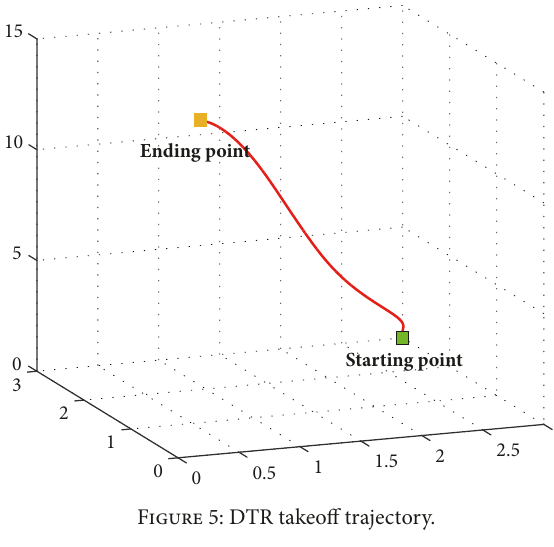
Figure 5: DTR takeoff trajectory.